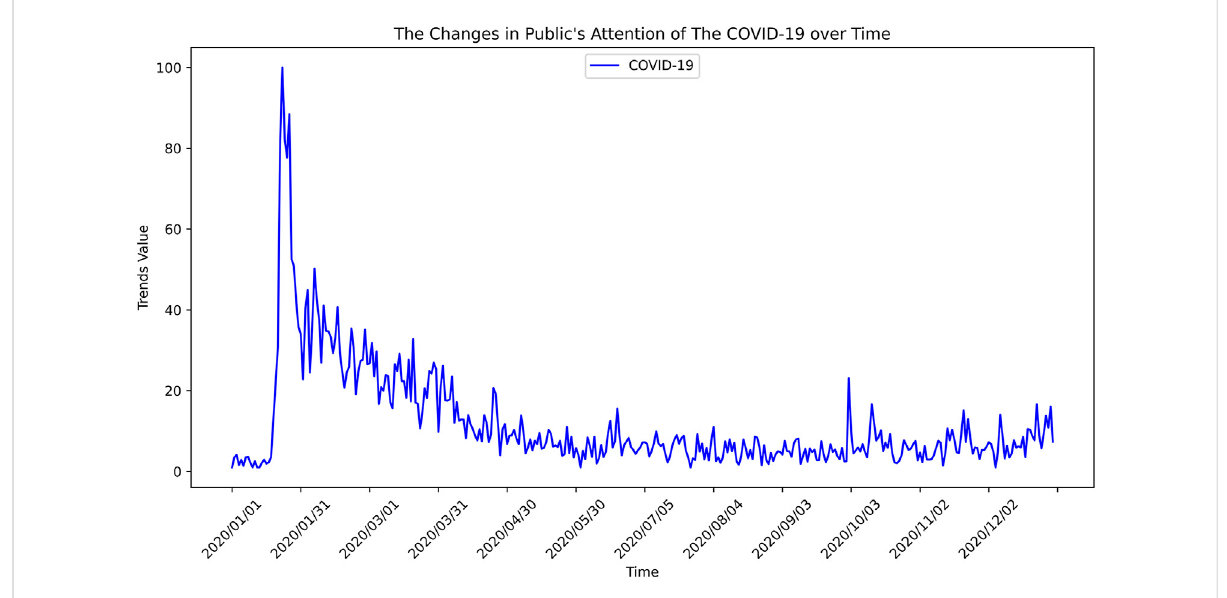
FIGURE 1 The changes in public ’ s attention of the COVID-19 over time.